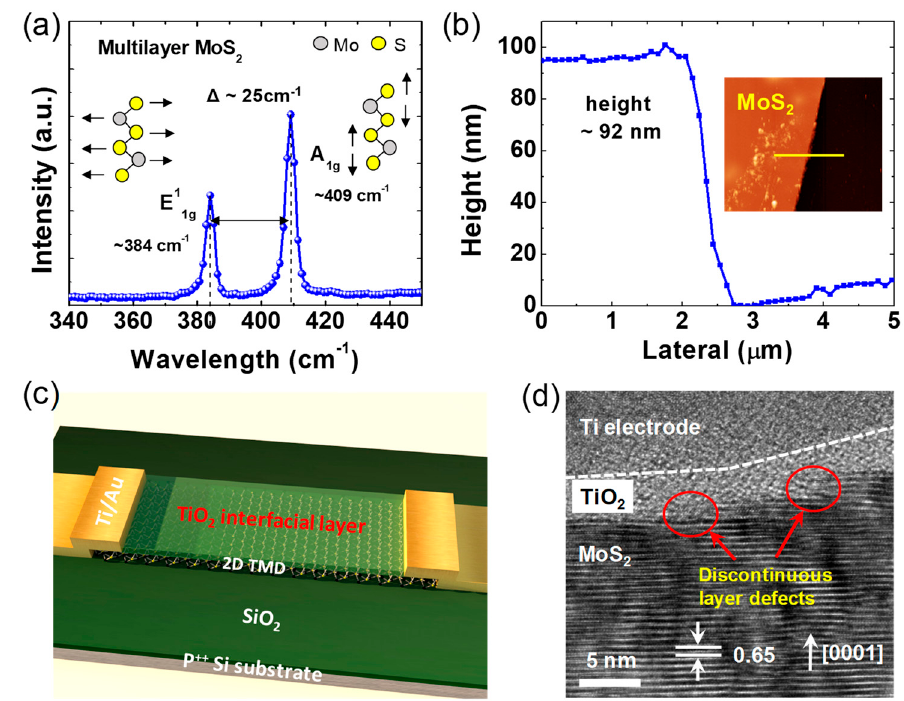
Figure 1. ( a ) Raman spectrum and ( b ) atomic force microscopy (AFM) analysis of a multilayer MoS 2 ; ( c ) 3D schematic image of a transition metal dichalcogenide field effect transistor (TMD FET) device; ( d ) a high-resolution transmission electron microscopy (HRTEM) image of the MoS 2 -TiO 2 -Ti stacked structure.